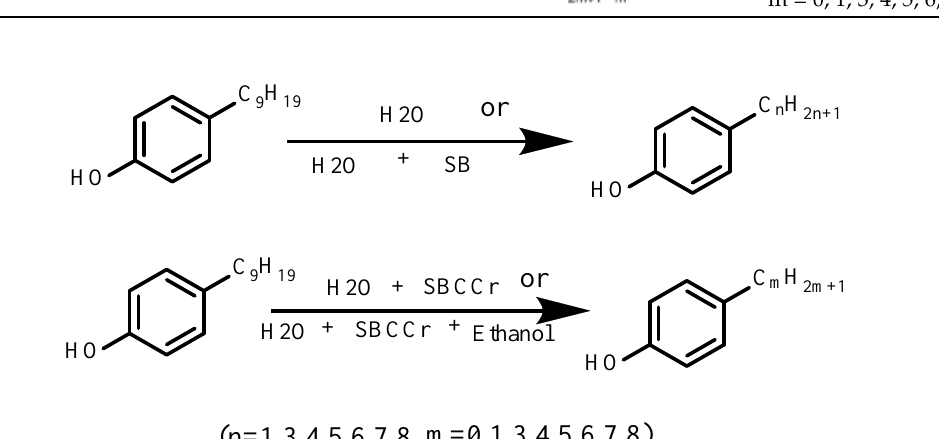
Scheme 3. Reaction process of nonylphenol.